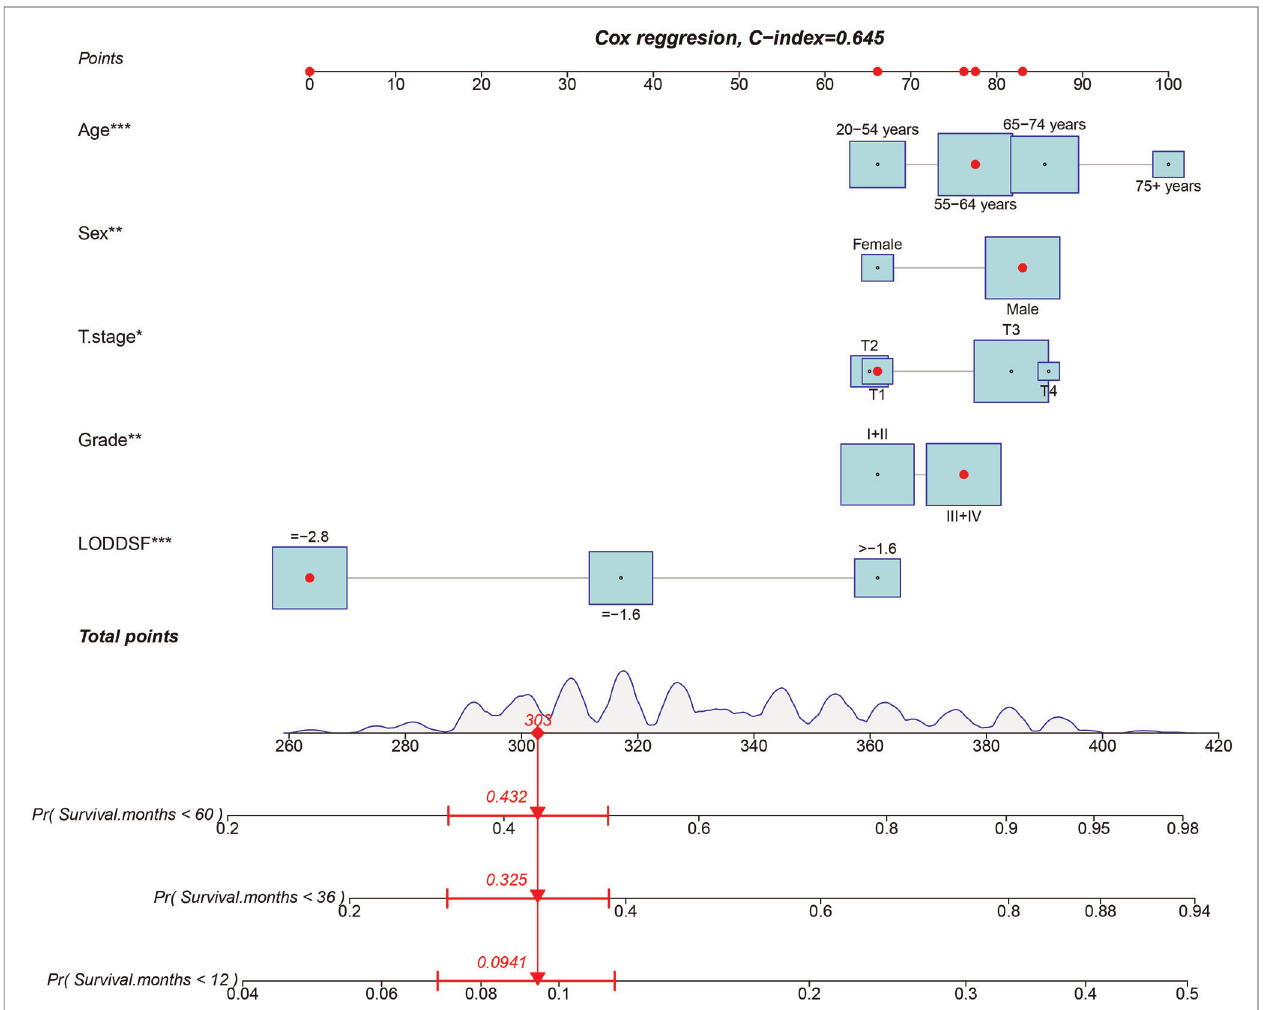
FIGURE 2 | Nomogram for predicting the probability of 1-, 3-, and 5-year overall survival in patients with esophageal carcinoma treated with neoadjuvant